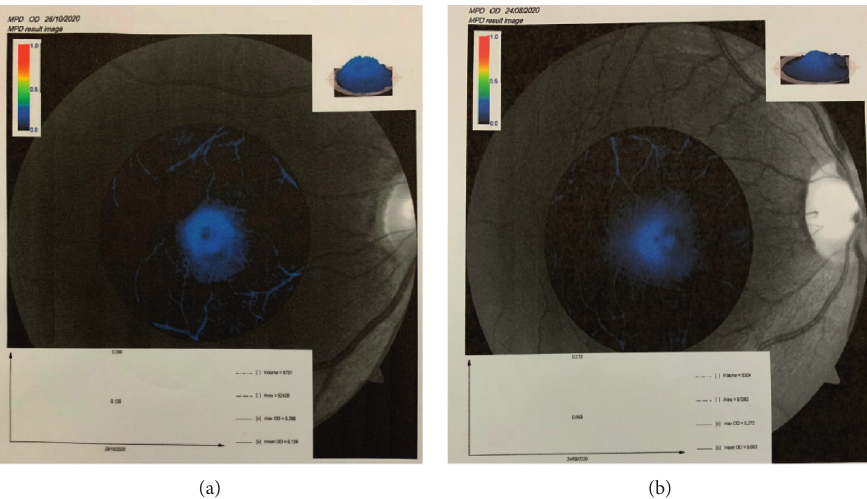
Figure 2: Comparison of MPOD image of 2 participants with different L / Z intakes. (a) Participant with an average of 11.98mg L / Z per day (mean MPOD of the right eye � 0.128 density unit) and (b) participant with an average of 0.20mg L / Z per day (mean MPOD of the right eye � 0.093 density unit). Table 5: Mean MPOD (volume, area, maximum, and mean). ( n � 113, excluded subjects partially completed questionnaires). MPOD volume 6,197.49 ± 1,745.37 MPOD area Max MPOD